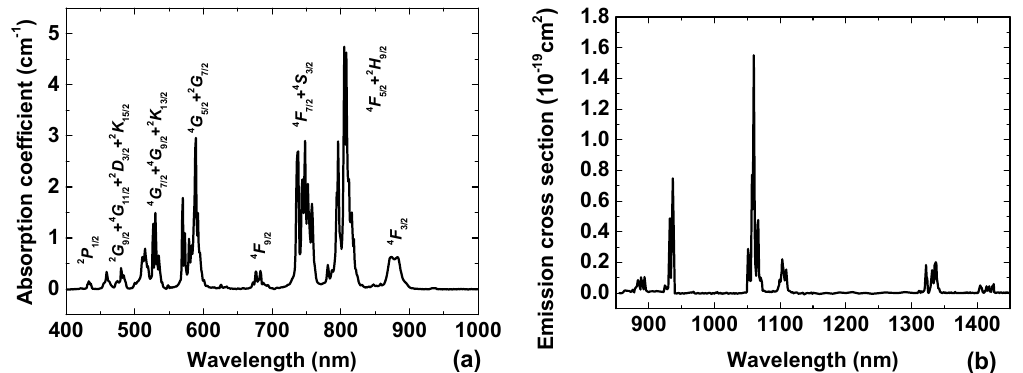
3 of 16 Figure 1. Photographs of as-grown Nd 3+ - and Er 3+ -doped GYSGG crystals: ( a ) Nd:GYSGG [5]; ( b ) Er:GYSGG [8]; ( c ) Er,Pr:GYSGG [9]; ( d ) Cr,Er,Pr:GYSGG [10]. Considering the maturity of the aforementioned crystals, the related data integrity, as well as the orientation of this paper, this review is focused on the performance of Nd 3+ - and Er 3+ -doped GYSGG lasers, and which is different from the representative review paper concentrating on the characterization of Nd:GSGG crystals [12]. This paper summarizes the development of Nd 3+ - and Er 3+ -doped GYSGG lasers at different wavelengths under various operations. The basics and methods for improving the laser performance are also demonstrated and discussed. A comparison of main performance indicators with the common garnet materials indicates that Nd 3+ and Er 3+ doped GYSGG crystals are good candidates for solid-state laser media for efficient high-power laser operation at several wavelength ranges. It is expected that this review will help researchers from related areas to learn about this material and promote its commercialization and application, including applications in space and environments with ionizing radiation. 2. Laser Performance of Nd 3+ -Doped GYSGG The absorption spectrum of Nd:GYSGG was measured by a Perkin Elmer Lambda 900 ultraviolet-visible-near infrared (UV/VIS/NIR) Spectrometer (PerkinElmer, Inc., Waltham, MA, USA), as shown in Figure 2a. There are eight absorption bands in the 400–1000 nm range originated from the ground state 4 F 9/2 and the peak is located at 808 nm. The Judd–Ofelt method for the calculation of oscillation strength, as well as the estimation of spectrum parameters for the radiative transitions (fluorescence branching ratio, transition rate and lifetime) are given in [6]. The stimulated emission cross-section was obtained by the Füchtbauer–Ladenburg (F-L) equation based